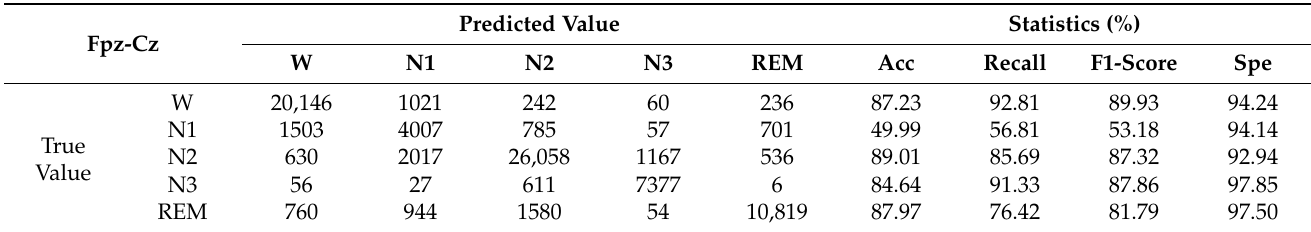
Table 3. Confusion matrix and classification performance of each class of the sleep EEG signal deep learning model based on bidirectional RNN on the Fpz-Cz channel.